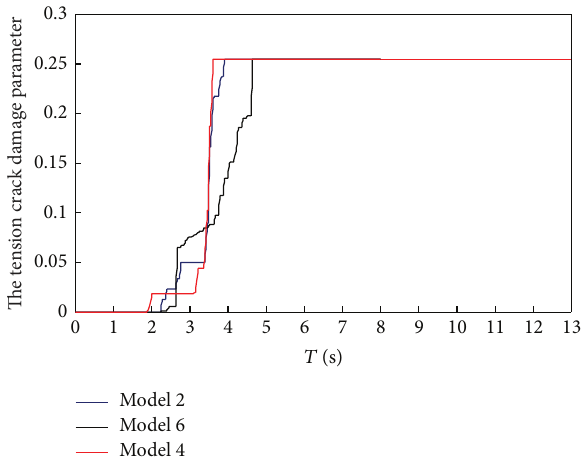
Figure 28: The parameter ratio of pier between windows and spandrel under Wolong ground